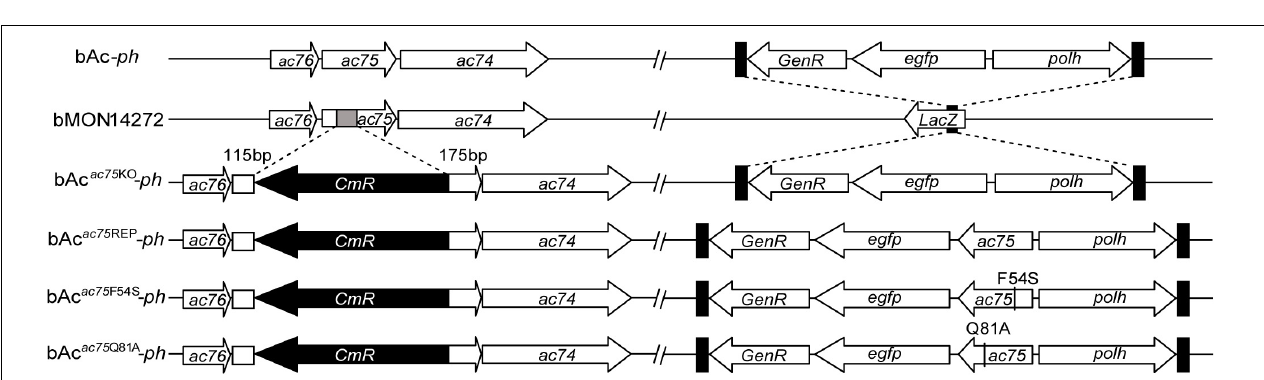
FIGURE 1 | Analyses of the transcription and expression profile of ac75 in infected cells. (A) Time course analysis of ac75 transcription. Sf9 cells infected with AcMNPV were collected at the indicated time points. Total RNA was extracted and total cDNA was obtained by reverse transcription. ac75 was amplified with specific primer pairs by PCR. (B) Western blot analysis of the expression of AC75 following aphidicolin treatment. AcMNPV infected cells were treated with 5 µ g/mL aphidicolin (+) or DMSO (–) at 0 h p.i. The cells were lysed and subjected to western blot analysis with anti-AC75 and anti-actin as primary antibodies at 24 h p.i.